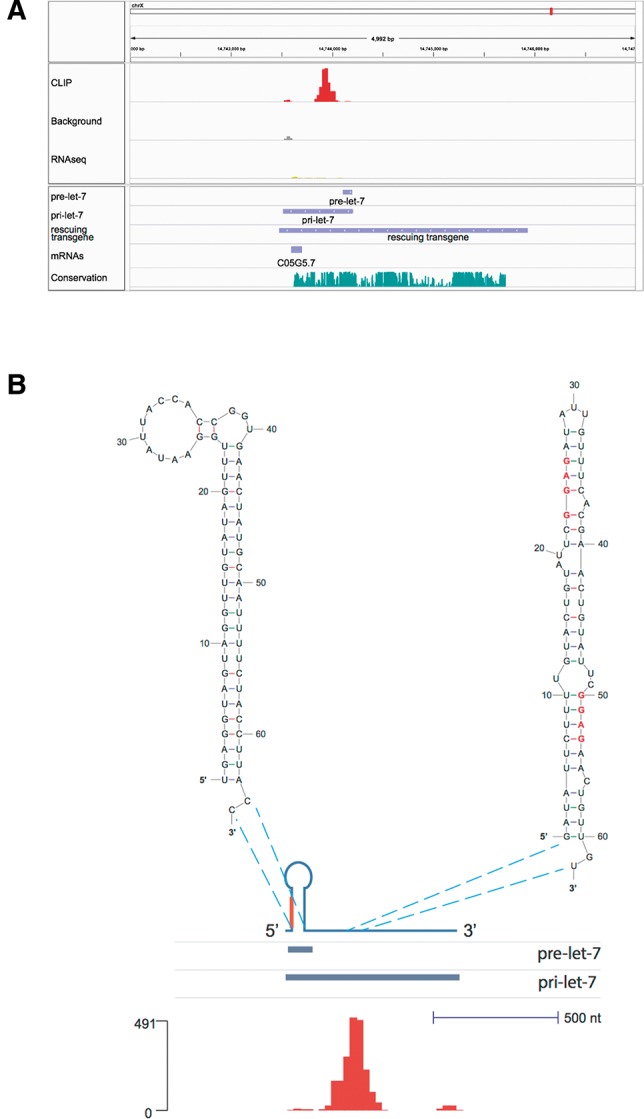
LIN-28 interactions with pri-let-7. (A) Map of LIN-28 interactions with let-7 precursors visualized by IGV. The number of reads in each line was normalized by the total number of mapped reads. Pre-let-7, pri-let-7, and a transgene capable of rescuing the let-7 mn112 and mg279 mutations are shown in the lower tracks (Reinhart et al. 2000). Since pri-let-7 is transcribed from the minus strand, its 5′ end corresponds to the right-hand end of the bar, while its 3′ end to the left. (B) The secondary structures of pre-let-7 and LIN-28 binding site (LBS) predicted using the mfold algorithm, superimposed to a schematic representation of pri-let-7, the pre-let-7, and pri-let-7 tracks, and a bar graph representation of the number of reads obtained by LIN-28 HITS-CLIP. For ease of representation, shown is a schematic drawing of pri-let-7 with annotation tracks and bar graph flipped horizontally compared with A, so that the 5′ end is on the left side, while the 3′ end is on the right side.